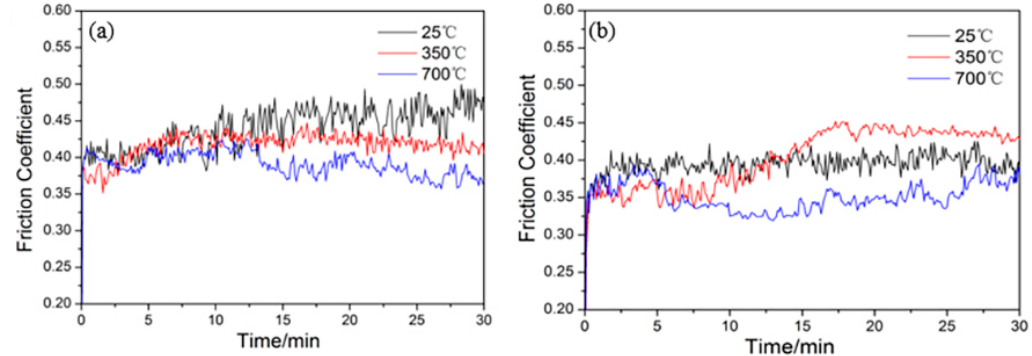
Figure 12. Variation curve of friction coefficient of Ti-6Al-4V alloy and alloying coating at different temperature. ( a ) Ti-6Al-4V alloy; ( b ) alloying coating.